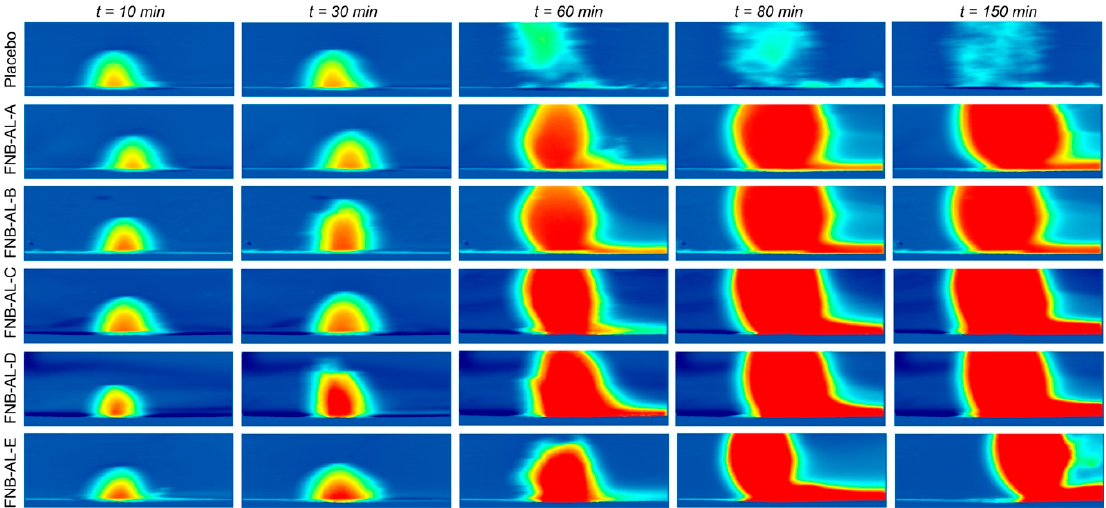
Figure 8. The selective snapshots of real-time UV imaging of FNB-NCs released from NCSM samples under flow conditions (100 µL/min) in SDS media, pH 8.1 (conc. 7.2 mg/mL), at λ max = 280 nm UV absorbance images obtained after 10, 30, 60, 120, and 150 min time intervals.